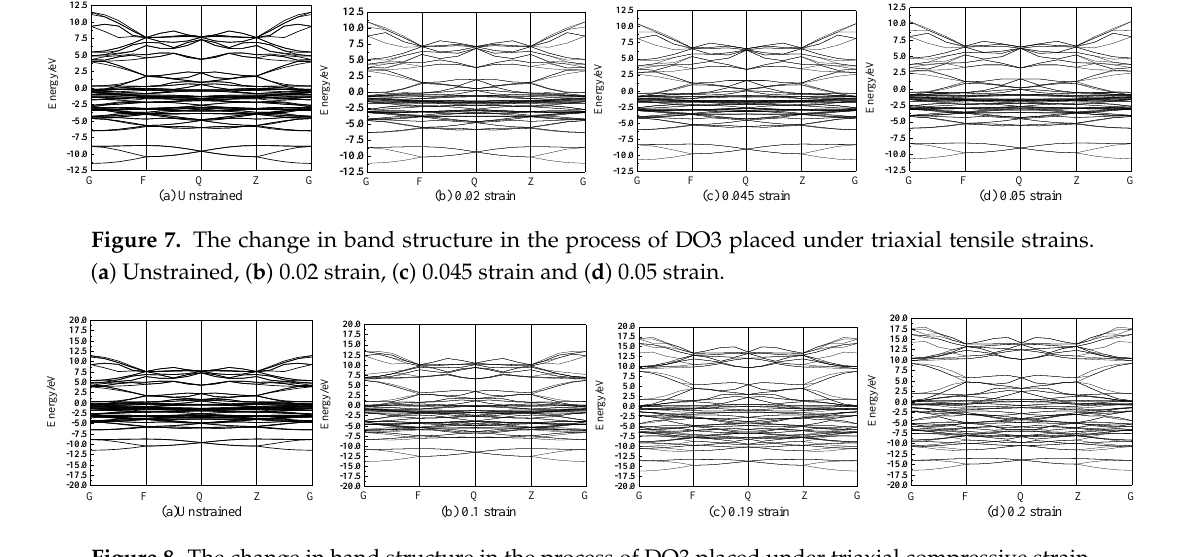
Figure 7. The change in band structure in the process of DO3 placed under triaxial tensile strains. ( a ) unstrained, ( b ) 0.02 strain, ( c ) 0.045 strain and ( d ) 0.05 strain.